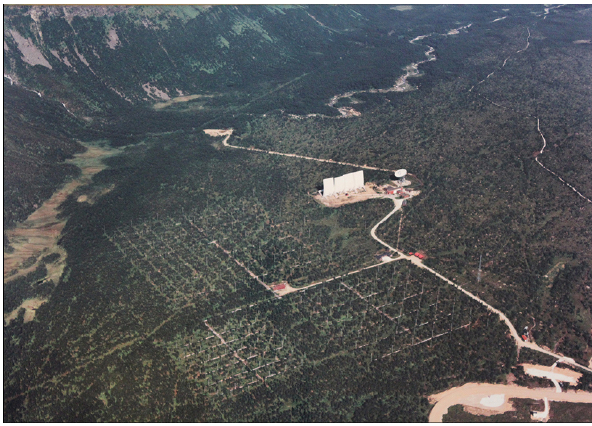
Figure 1. Aerial photo of the Heating antennas and IS radars at the Ramfjordmoen site from 1996. (Photo credit: Fjellanger Widerøe